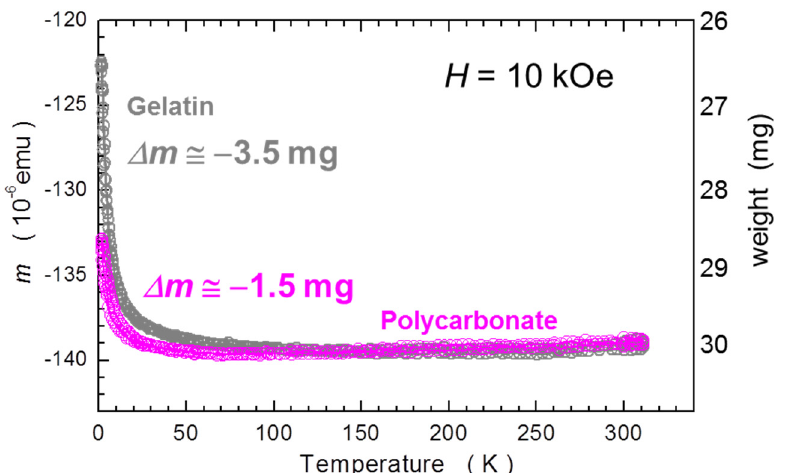
Figure 2. Temperature dependence of the magnetic moment m of single gelatin (grey) and polycar- bonate (magenta) capsules. Magnetic data are normalized between themselves and a related standard mass of 30 mg. The magnitude of the paramagnetic shift of m at low temperatures is expressed as an equivalent “loss of mass” of the capsules, Δ m . The capsules are harness-free mounted in a diameter-reduced straw, as explained in Section 2.2.